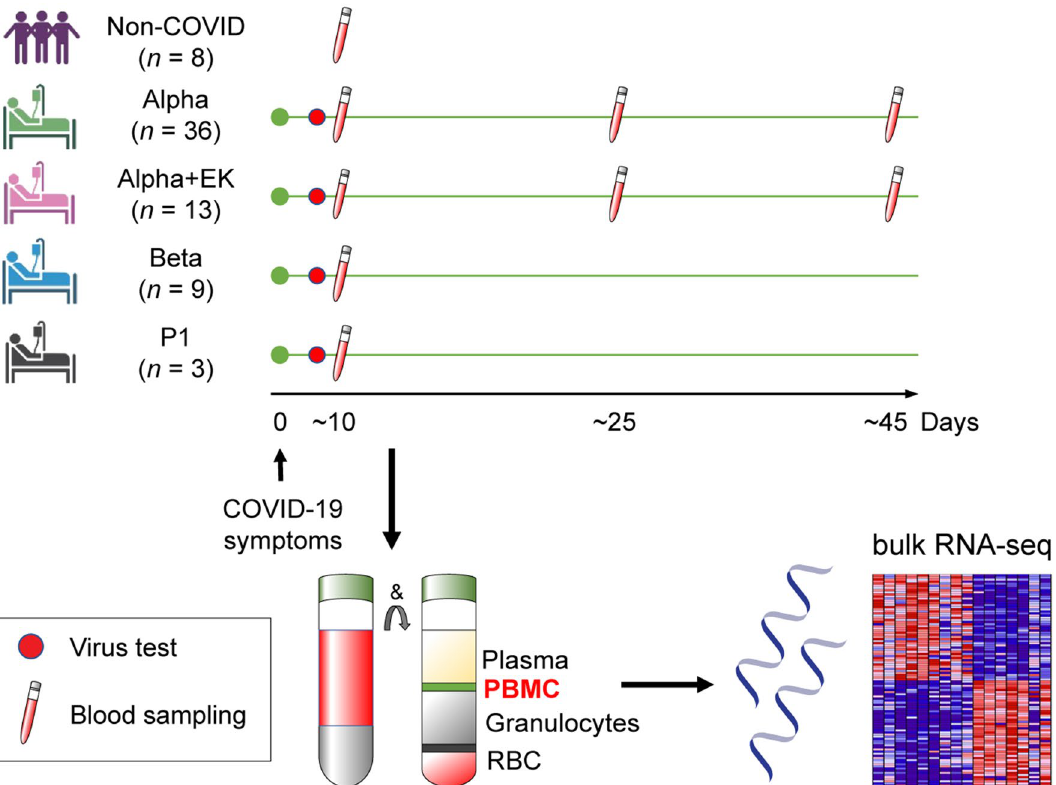
Figure 1. Experimental design. Schematic presentation of the patient cohort and the experimental workflow. COVID-19 patients were diagnosed, and the variants were identified through whole viral genome sequencing. Buffy Coast (BC) cells including PBMCs and granulocytes were purified from blood drawn at different times after symptomology and RNA-seq was performed at a depth of 215 million reads per